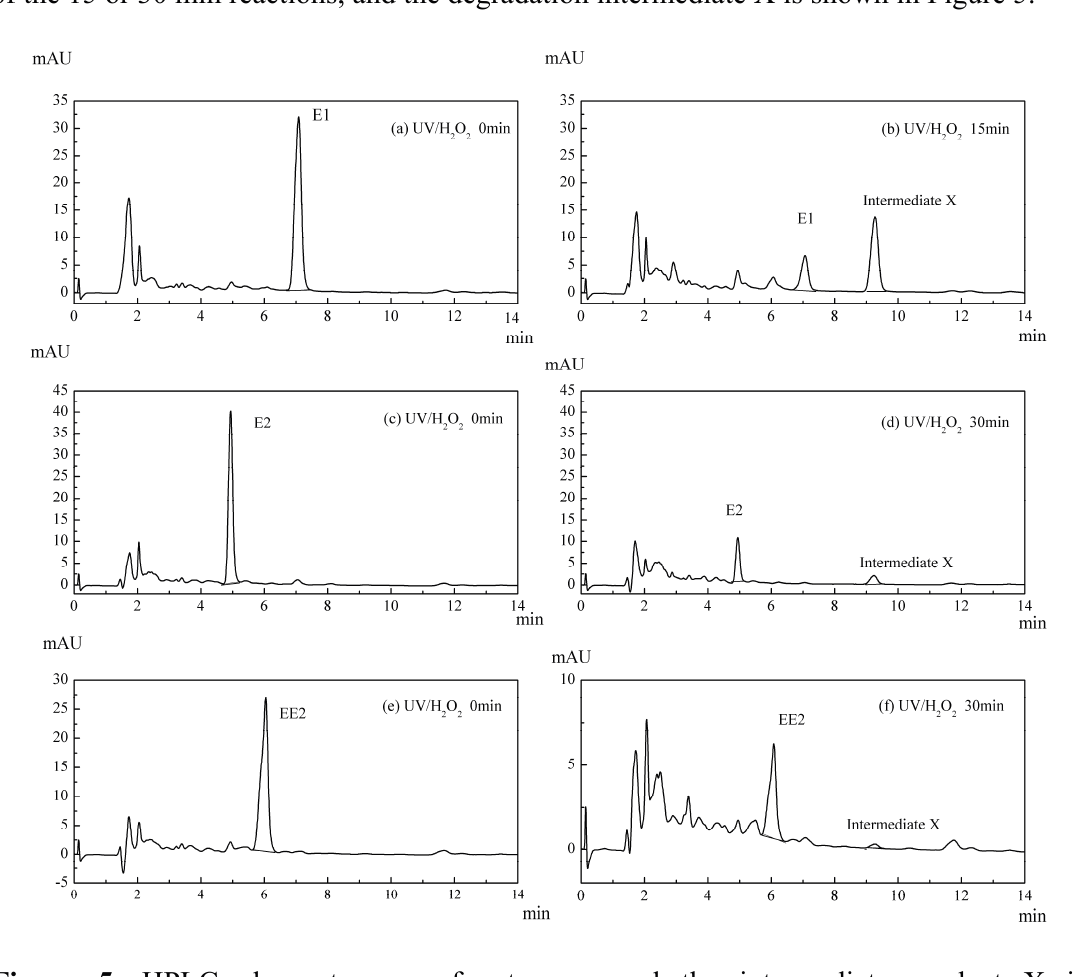
Figure 5. HPLC chromatogram of estrogens and the intermediate product X in UV/H 2 O 2